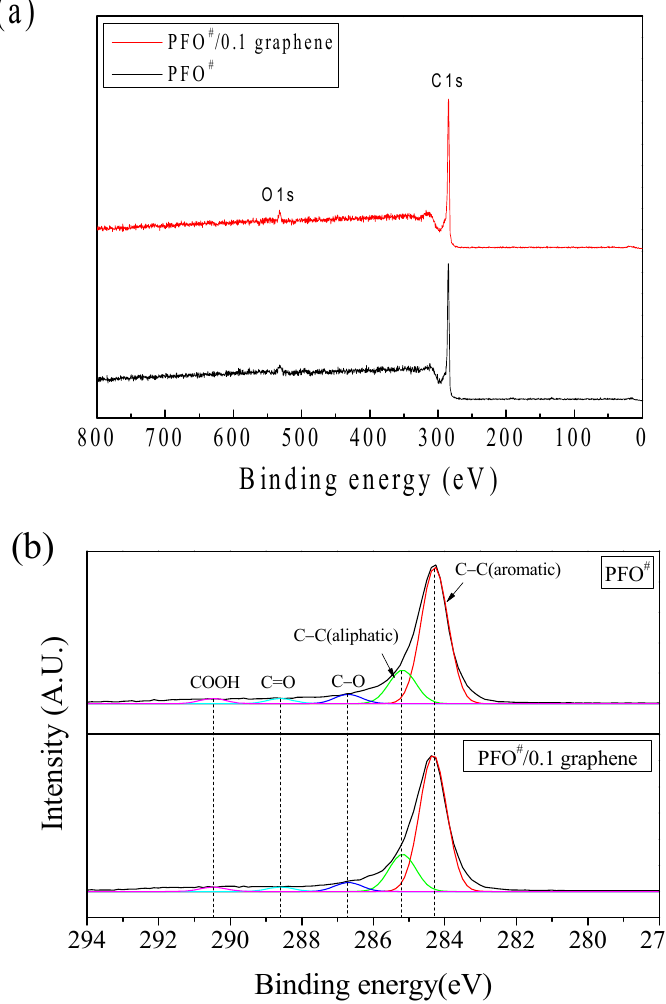
Figure 9. ( a ) Wide-scan XPS spectra and ( b ) C 1s XPS spectra of PFO # -based carbon fibers. Table 5. Area Ratios of Chemical Bonding Peaks from C 1s XPS Spectra.